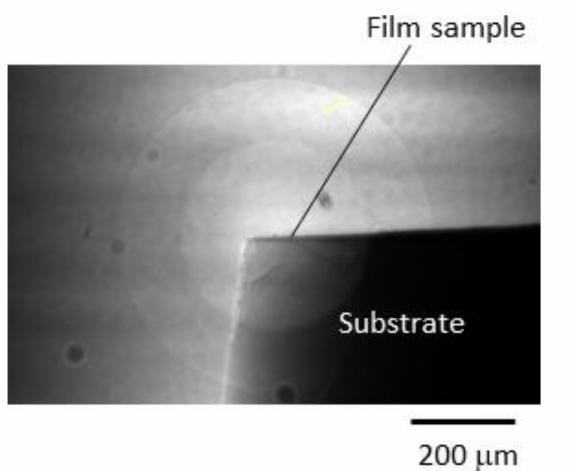
Figure 3. Radiograph obtained by the 2D X-ray detector. A light-receiving fiber for the PL emission and an array spectrometer MCPD-9800 (Ot- suka Electronics Co., Ltd., Hirakata-shi, Osaka, Japan) were placed roughly perpendicular to the X-ray beam. The spectrometer consisted of flexible optical fiber, slits, grating, and array-detecting elements. It can measure light with wavelengths of 360–1100 nm with